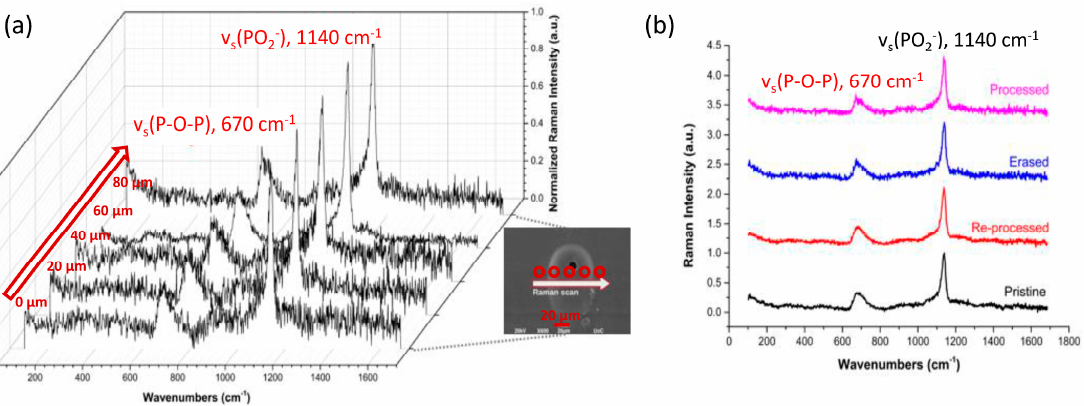
Figure 5. ( a ) Raman mapping spectra of a processed AgPO 3 glass cross-section with steps of ~20 μ m starting right before the processed area on pristine glass. Inset SEM image shows the processed area scanned and the direction of the Raman scanning across the processed area and the laser-induced void (for clarity the arrow and dots are shown below the void). ( b ) Surface Raman spectra of pristine, processed, erased and reprocessed AgPO 3 glass. All spectra were normalized at 1140 cm − 1 to facilitate comparison.